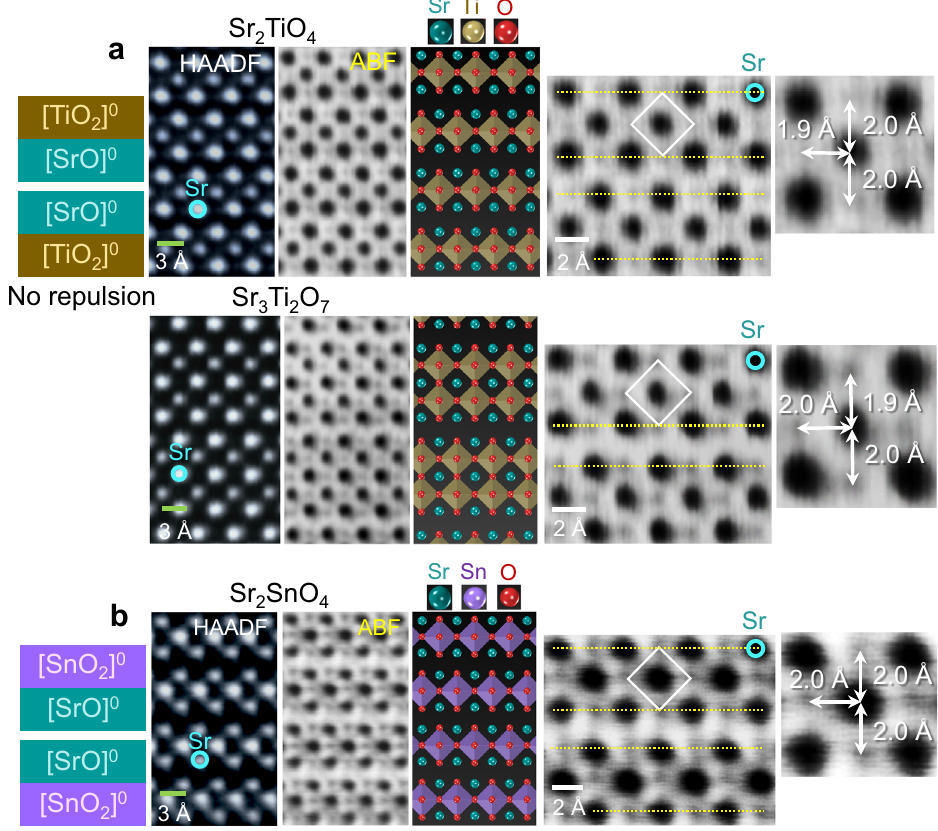
Fig. 5 STEM images showing the structure of Sr-based RP oxides. Atomic-column-resolved images were acquired in a Sr 2 TiO 4 and Sr 3 Ti 2 O 7 and b Sr 2 SnO 4 , as listed in Supplementary Table 1. Because these RP oxides have no effective charge in [SrO] sublayers, no distortion of oxygen octahedra is identi fi ed in each structure. Magni fi ed ABF images directly provide quantitative information on the Ti – O and Sn – O bond